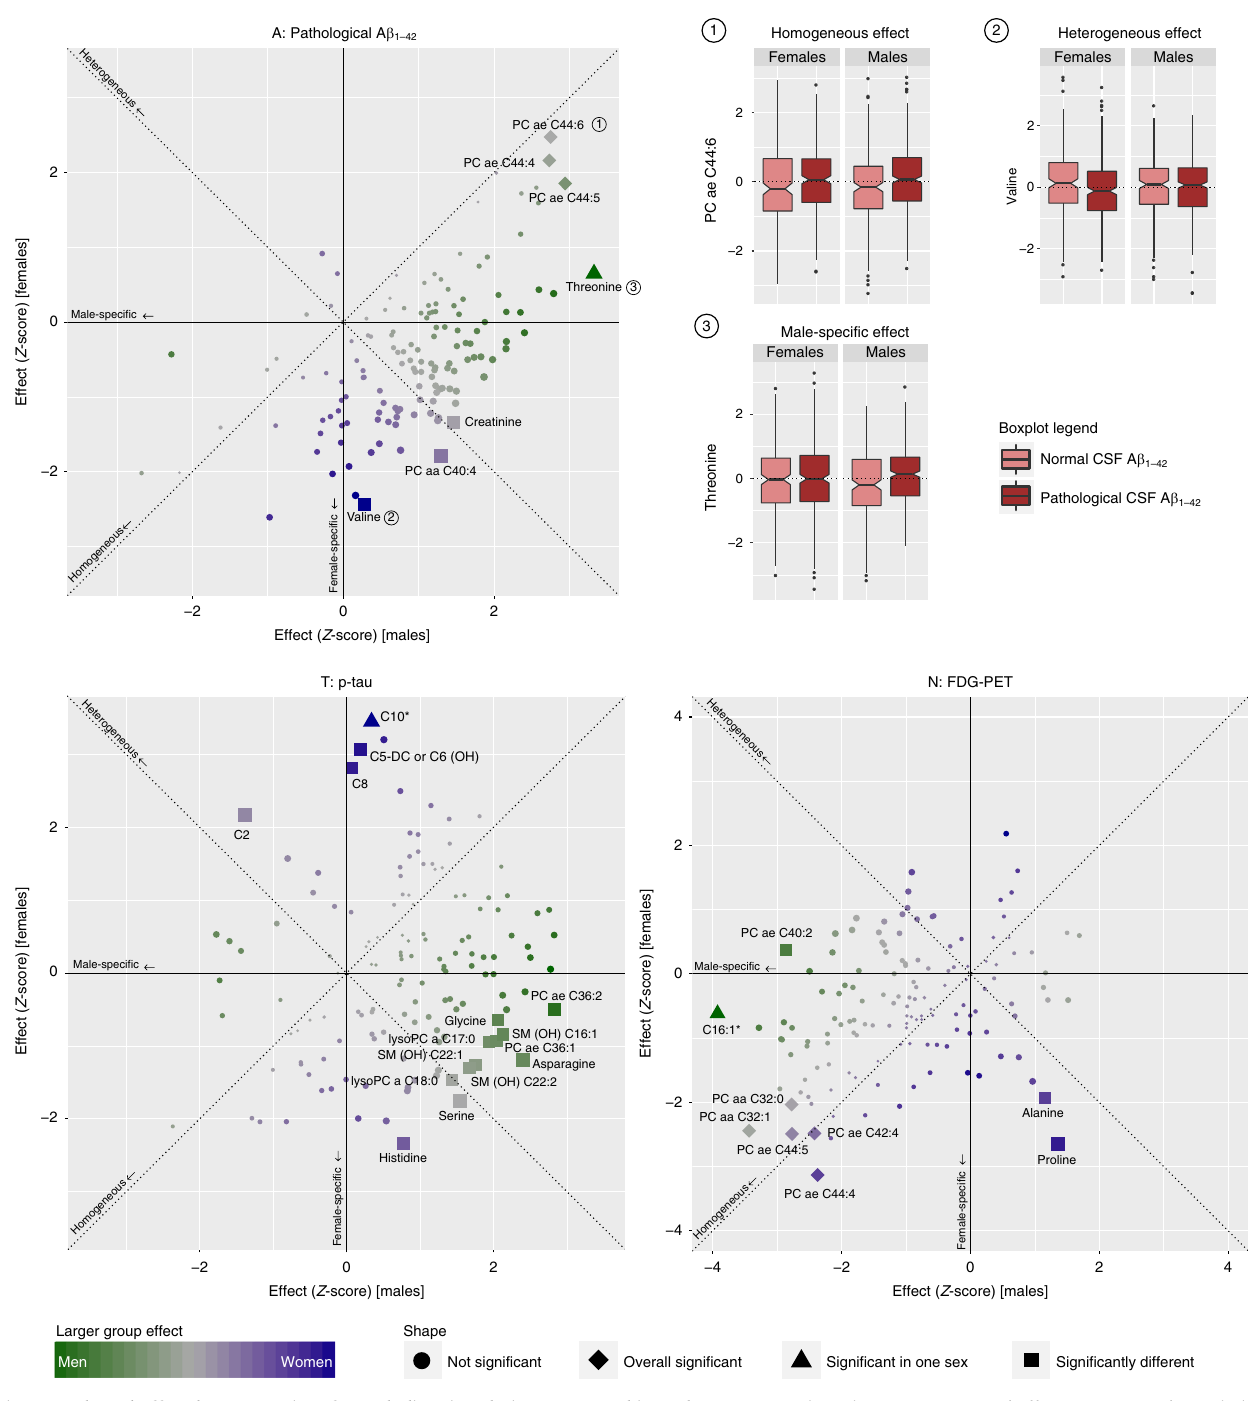
Fig. 1 Sex-based effect heterogeneity of metabolites in relation to A-T-N biomarkers. Scatter plots showing Z scores of effect estimates of metabolite associations with A-T-N biomarkers for males ( x axis) versus females ( y axis). Homogeneous effects (i.e., those with same effect direction and comparable effect size) are located close to the diagonal, heterogeneous effects are located close to the anti-diagonal, and sex-speci fi c effects are located close to the x axis for male-speci fi c and y axis for female-speci fi c effects. Homogeneous overall signi fi cant results are drawn as diamonds, effects with signi fi cant heterogeneity are drawn as rectangles, and effects signi fi cant in only one sex are drawn as triangles. Metabolites additionally marked by an asterisk are signi fi cant in one sex only and simultaneously show signi fi cant heterogeneity. Sex-speci fi city is further illustrated by a color scale (blue: females; green: males). On the upper right panel, example boxplots of metabolite residuals (obtained by regressing out included covariates) for each effect type are shown separately for females and males with (in dark red) and without (in light red) CSF A β 1 – 42 pathology, respectively. Source data are provided as Source Data